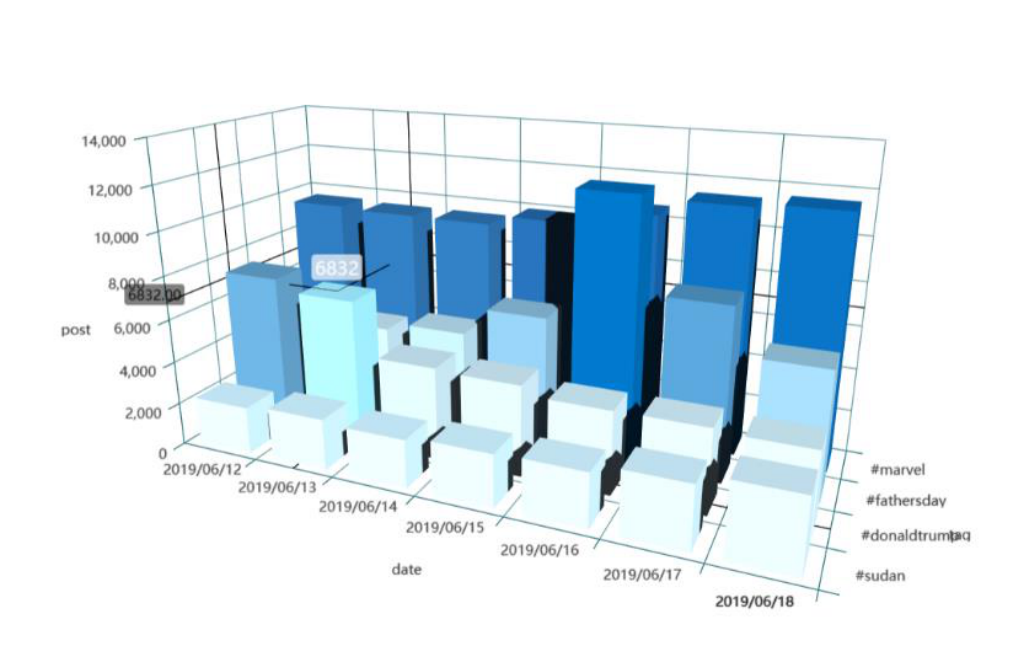
Figure 6 visualization of the hashtag time-varying view in 3D